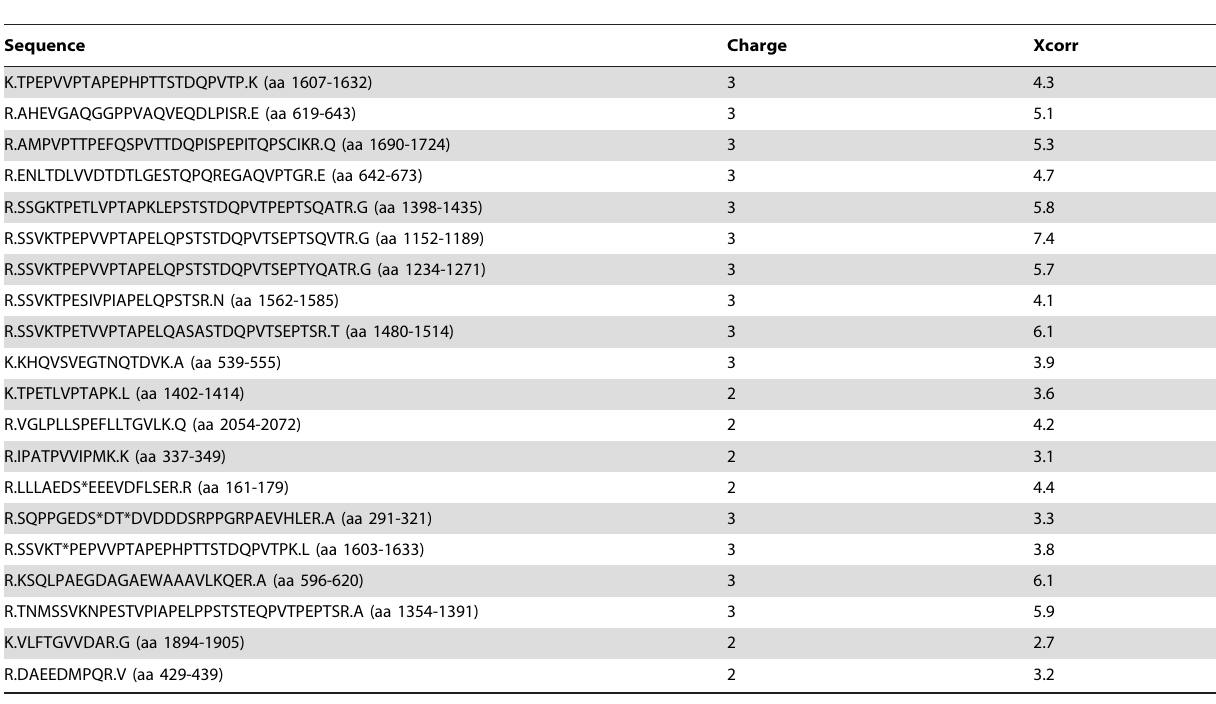
Table 1. MDC1 peptides identified by mass